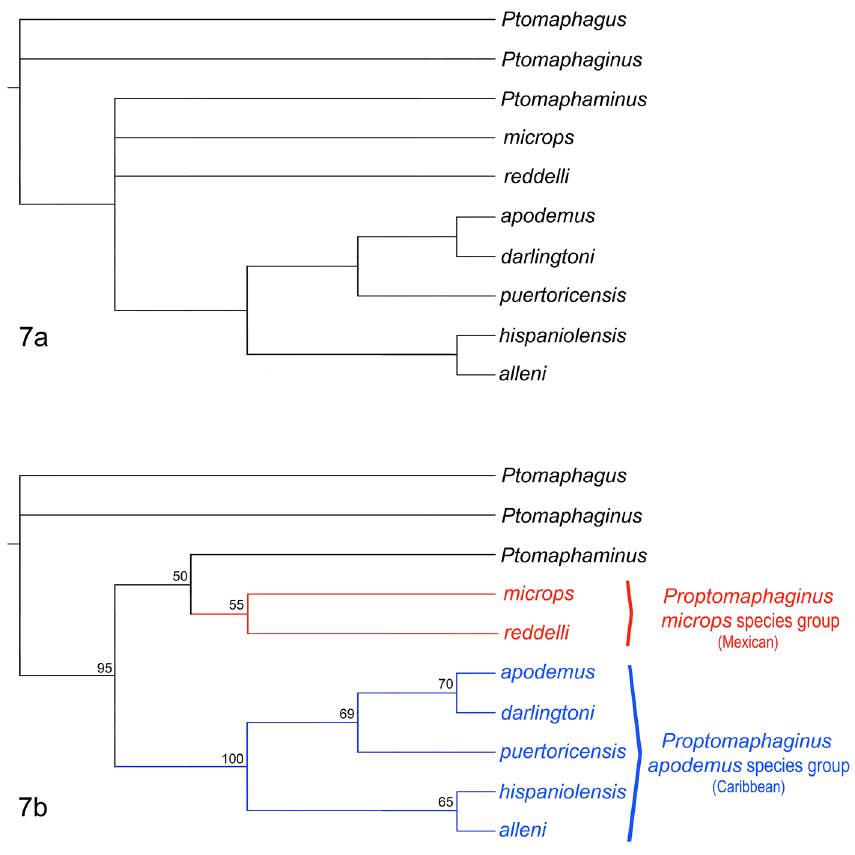
Figure 7. Phylogeny of the genus Proptomaphaginus . ( a ) Strict consensus tree of the 3 most parsimonious trees obtained from an exhaustive search based on our character matrix. ( b ) Tree obtained after a heuristic search with 10,000 replicates. Bootstrap support (if ≥ 50) indicated at each node